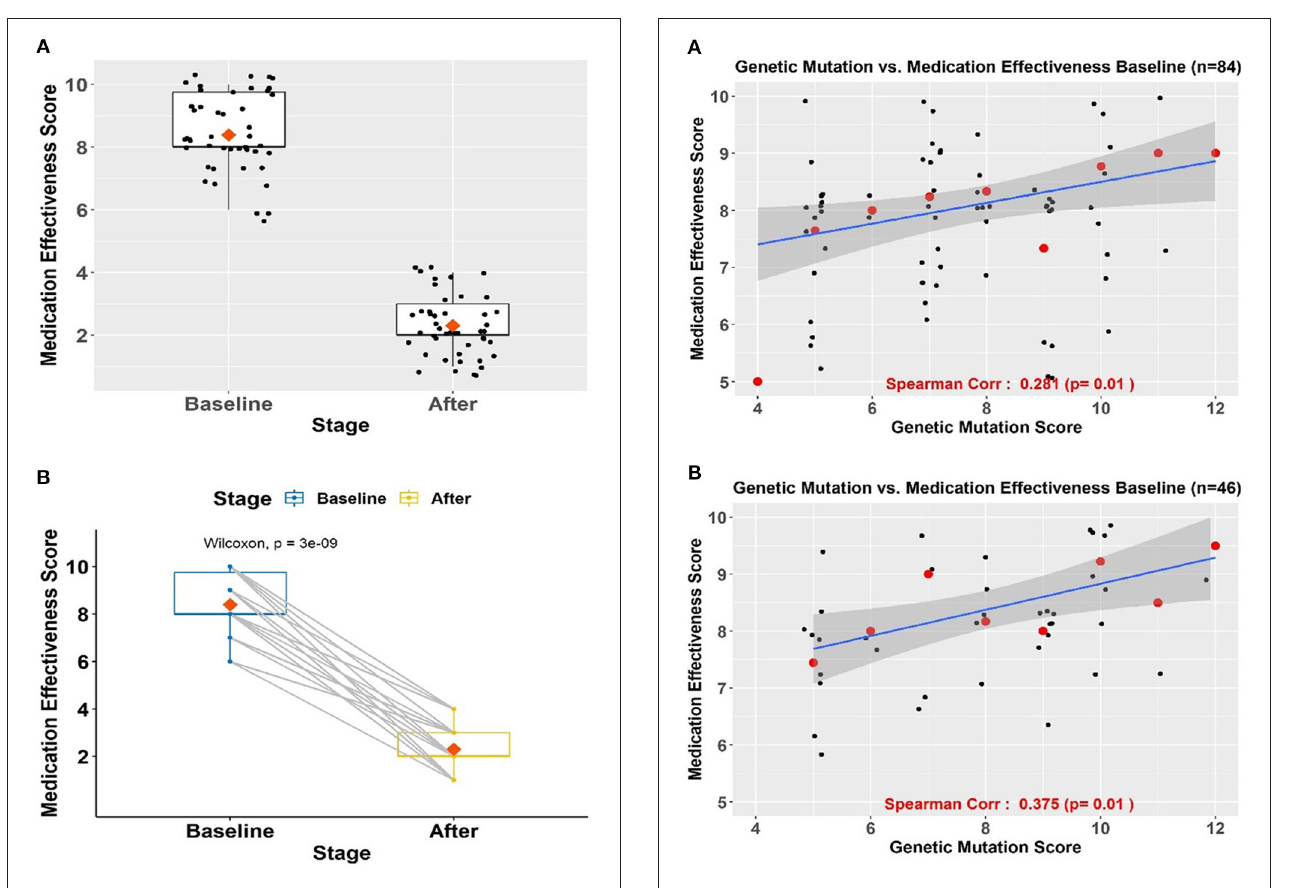
FIGURE 4 | (A,B) Change in treatment effectiveness scores in 46 patients on mental health-related disability.